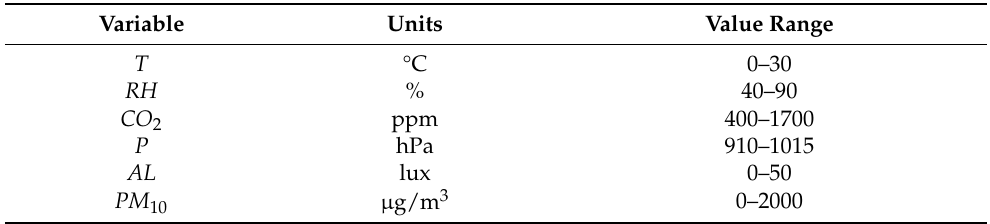
Table 1. Variables measured by the sensors at “Mrakova